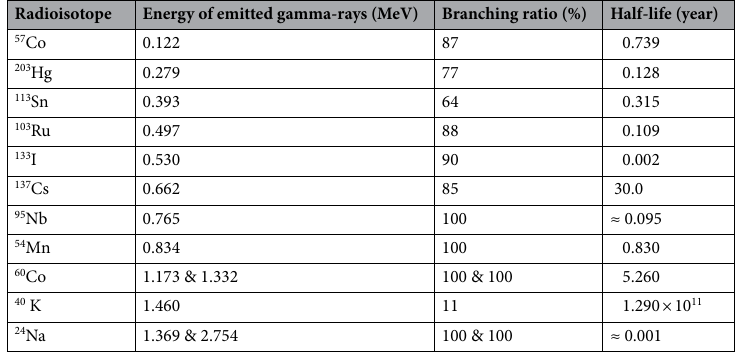
Table 1. Characteristics of common radioisotopic gamma-ray sources 18